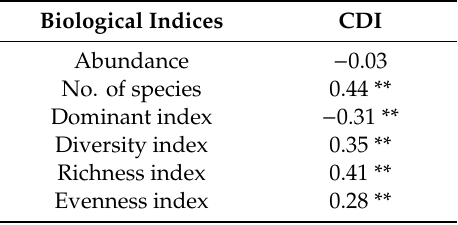
Table 4. The correlation coe ffi cients between the community dynamic index of epilithic diatom (CDI) and biological indices in the Hantangang River from 2012 to 2015. ** p <